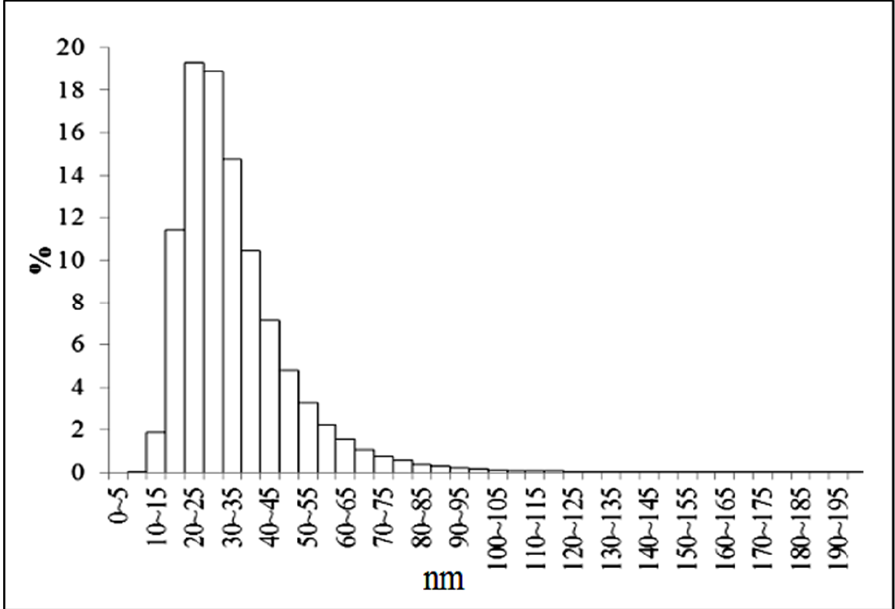
Figure 7. Particle size distribution for the zirconia nanopowder.